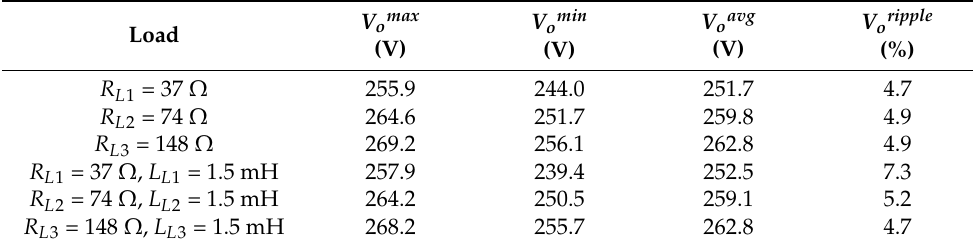
The average output voltage V oavg and the ripple V oripple are indicated in Table 12. Simulated results indicated that the voltage amplitudes values were only marginally affected by the load, even when it was ohmic-inductive. Table 12. CTU output voltage simulation results. Table 12. CTU output voltage simulation results.